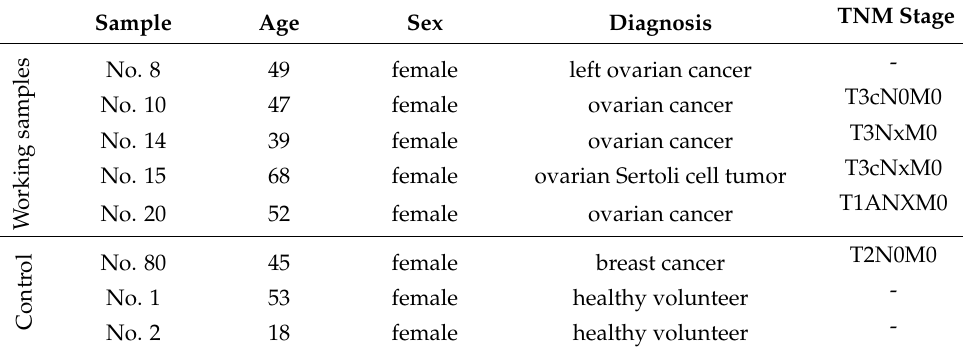
Table 4. The characteristics of blood plasma